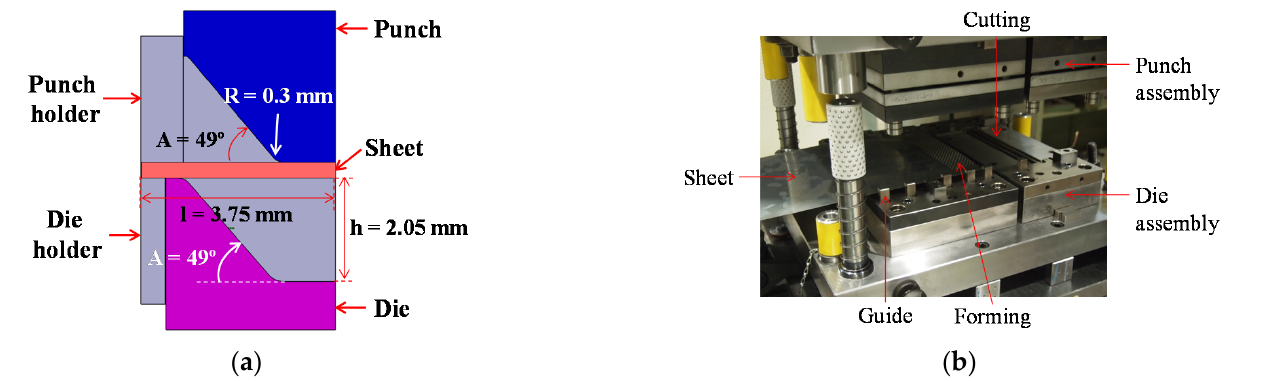
Figure 2. ( a ) Initial design of punch and die and ( b ) experimental setup for progressive two-stage forming.